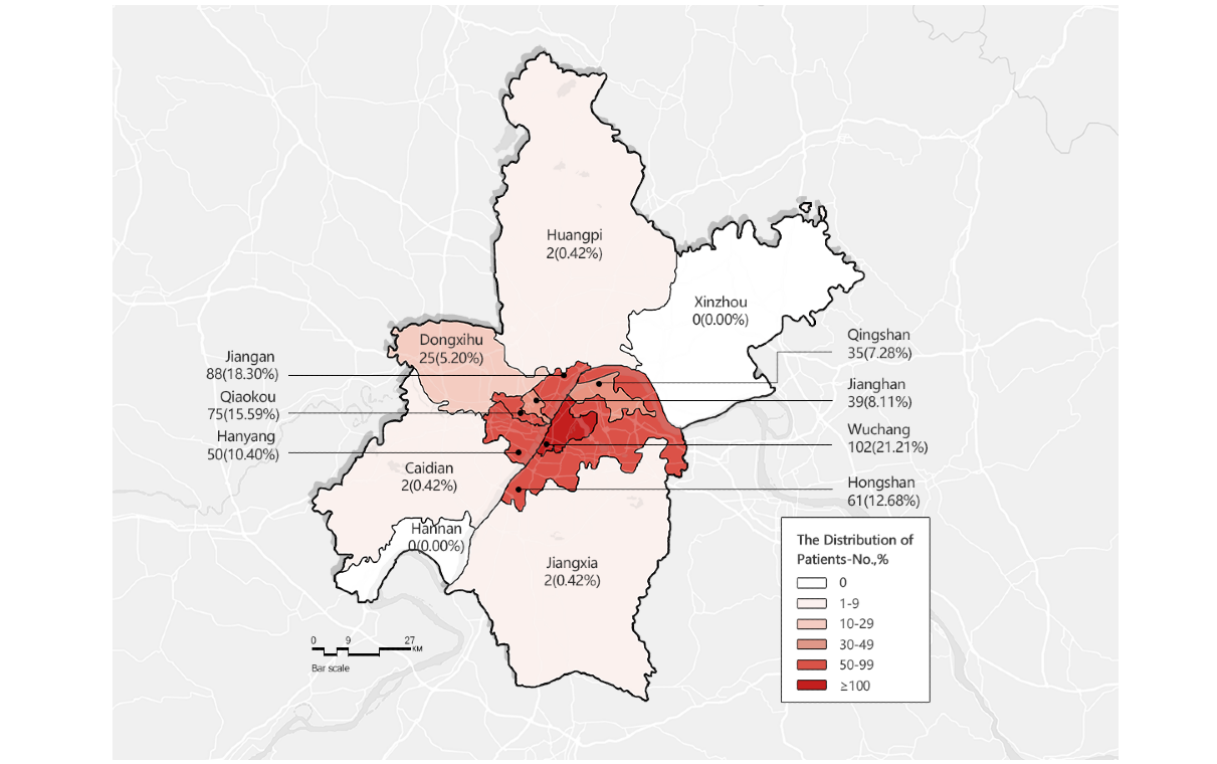
Figure 4. The distribution of patients throughout